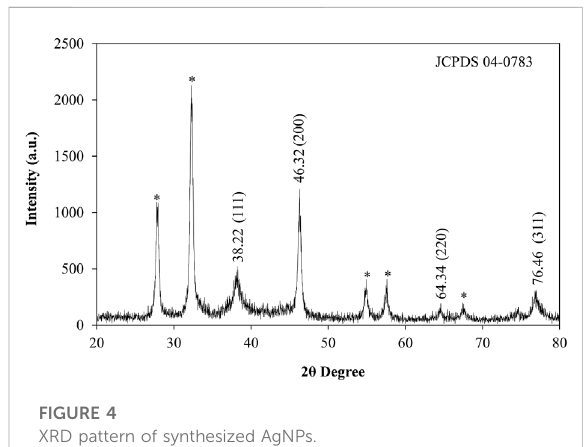
FIGURE 4 XRD pattern of synthesized